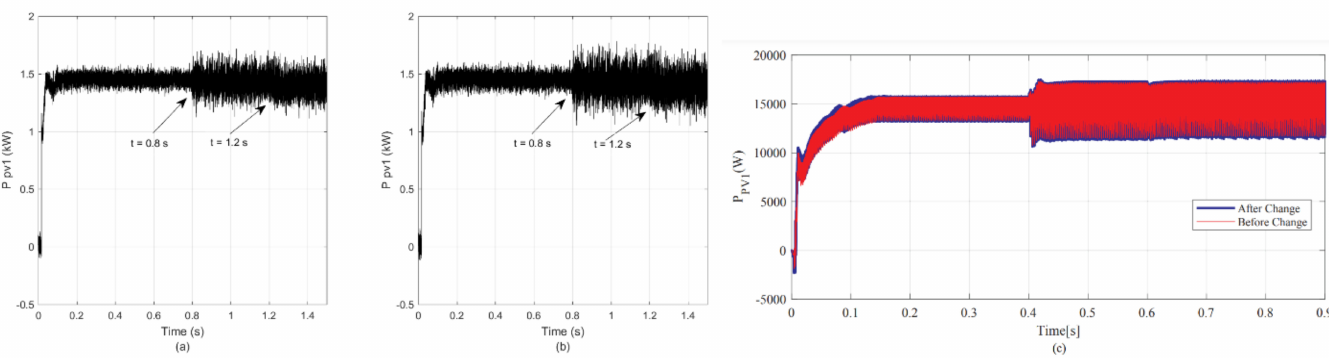
Figure 9. Injected power by DG-DC1 (PV1) with two different sets of MG parameters, ( a ) with the first set, ( b ) under the second set, ( c ) with two different sets of MG parameters in ref [19].